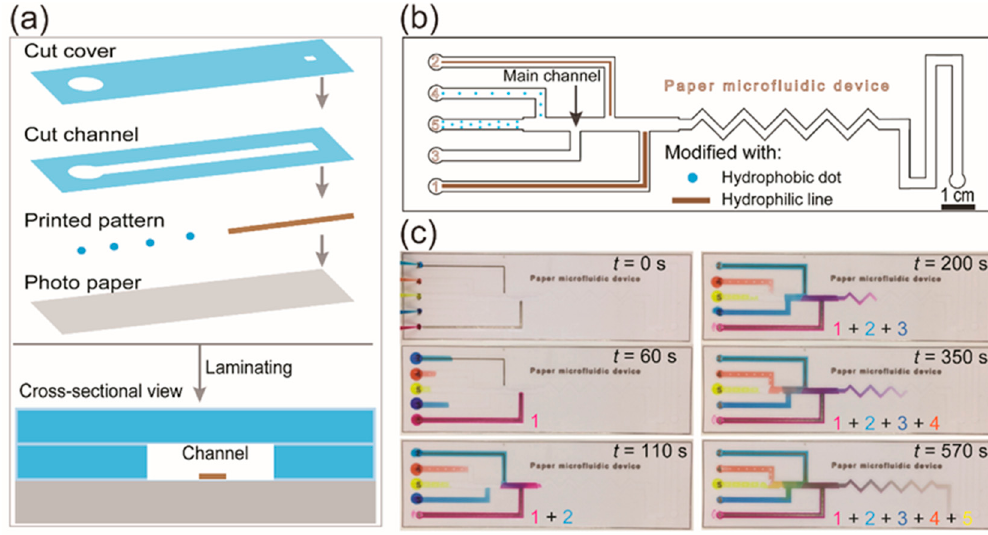
Figure 3. ( a ) Schematic illustration of fabrication and ( b ) programming fluid transport in a µPAD, respectively. ( c ) Fluid transport in microchannels was controlled quantitatively by using printed hydrophilic and hydrophobic patterns. Reprinted with permission from the authors of [99]. Copyright